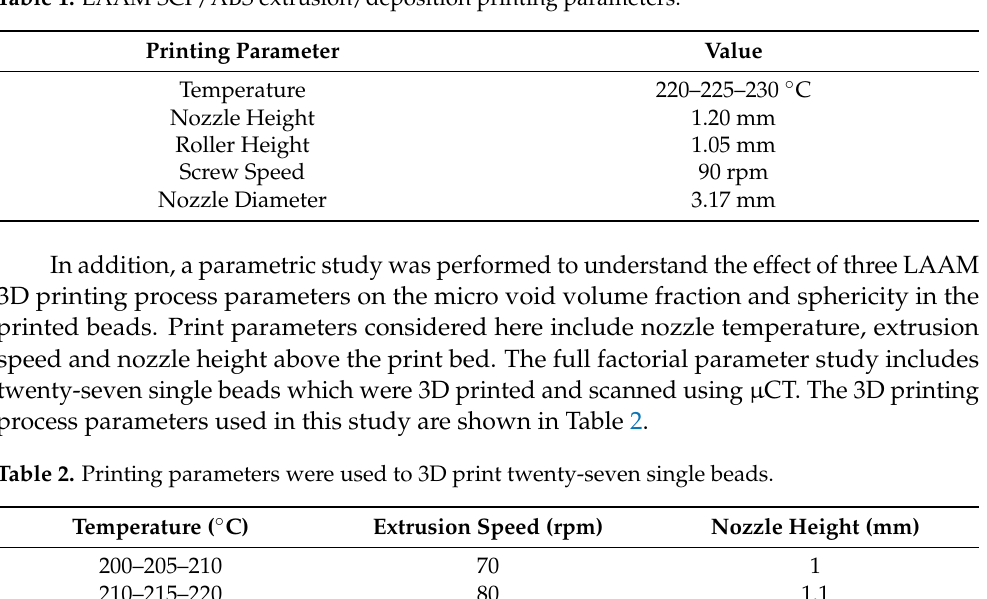
Figure 1. ( a ) Baylor’s custom large-area additive manufacturing (LAAM) system. ( b ) Plastic roller attached behind the nozzle. Table 1. LAAM SCF/ABS extrusion/deposition printing parameters.